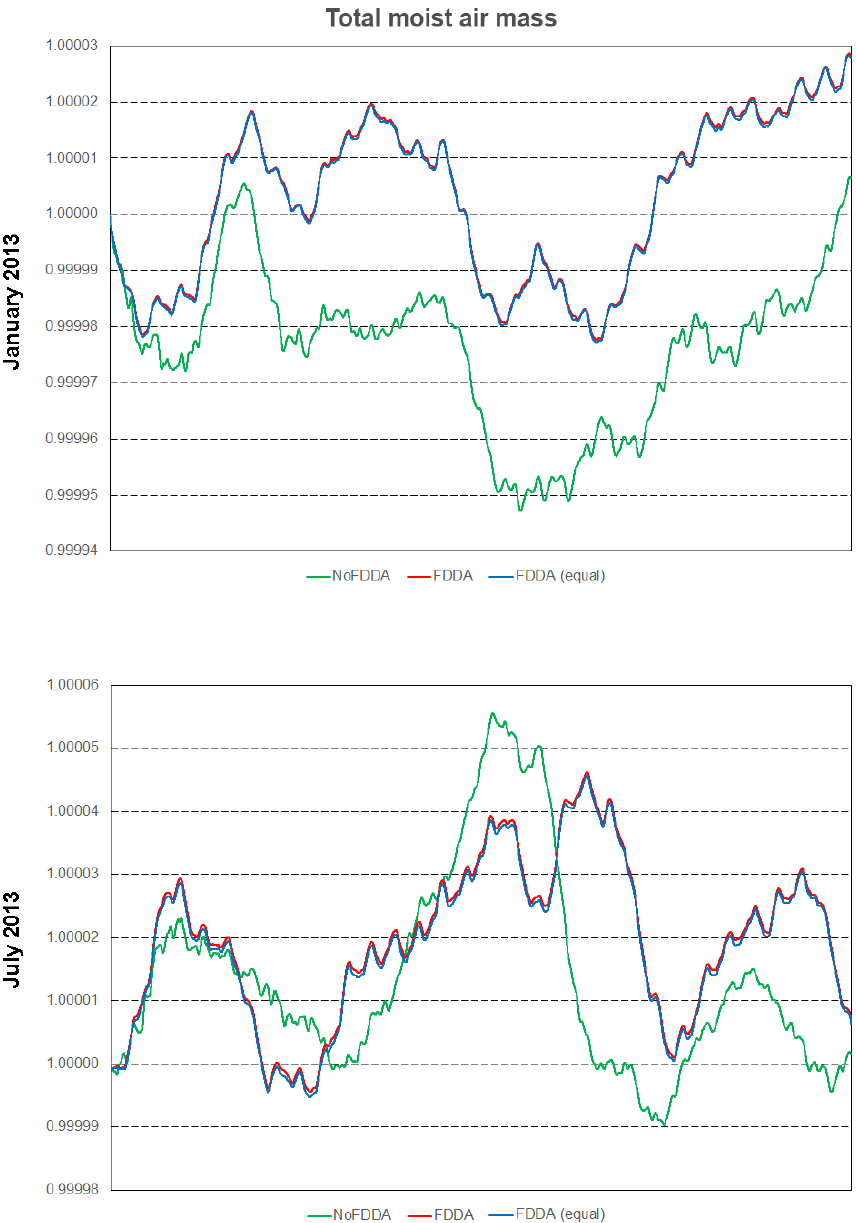
Figure 18. Time series plots of total moist air mass scaled to their initial values for the two test periods. Results are from MPAS-A without FDDA (green line), MPAS-A using weaker q v nudging (red line), and MPAS-A using equal nudging for all variables (blue